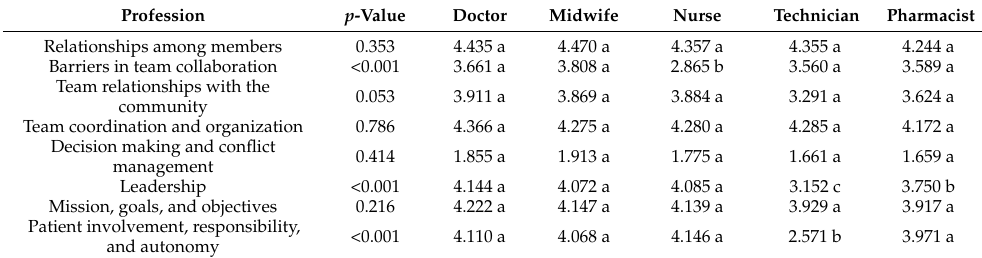
Table 3. Reported CPAT scores categorized by profession (N = 261 − N HUH = 98; N BRPH = 96, N HGH = 67).